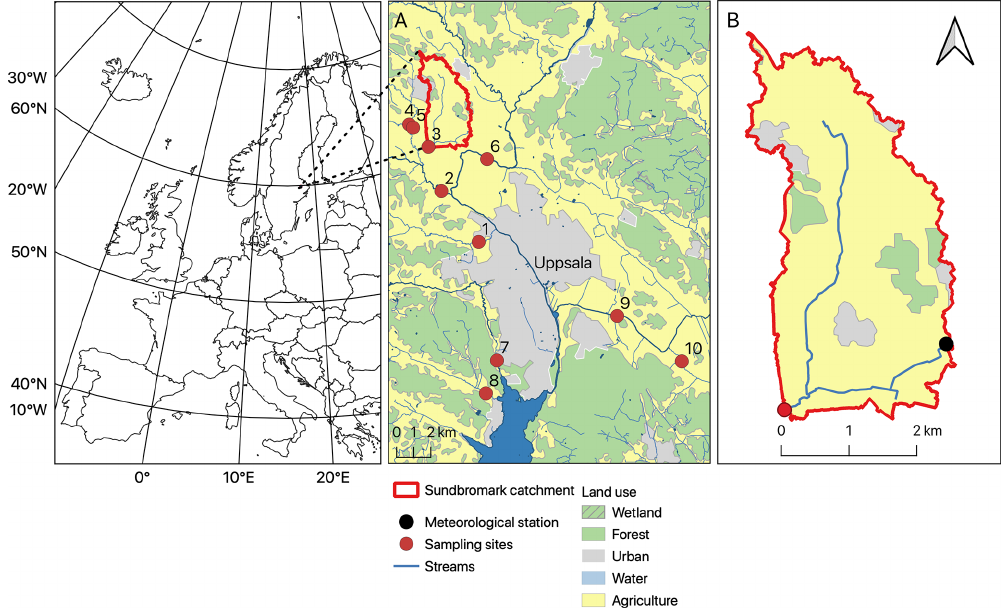
Figure 1. Location of the study with (a) sampled sites of the spatial survey and (b) the Sundbromark (SBM) catchment. Catchment delineation and land use distributions are given according to GSD elevation data, grid 2 + (©Swedish Land Survey) and CORINE Land Cover 2018 (European Environment Agency).